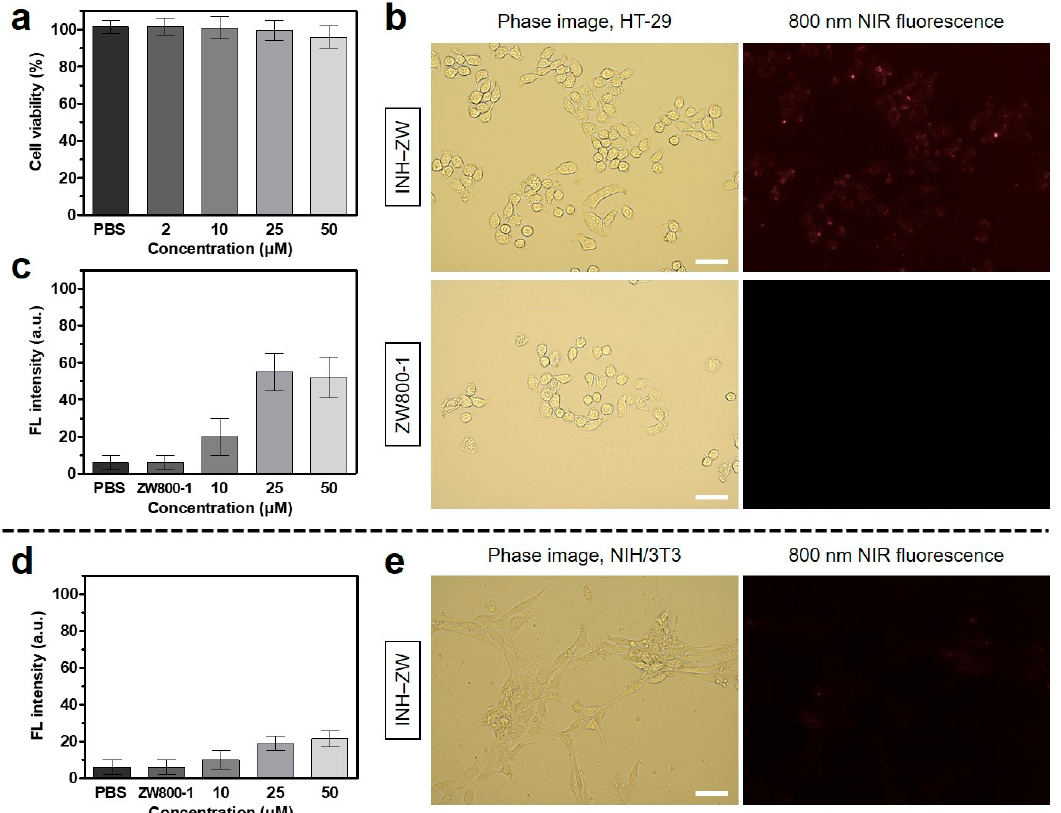
Figure 3. ( a ) Cell viability assay of the INH–ZW conjugate using HT-29 cancer cells. The percentage cytotoxicity was determined after 24 h of treatment with various concentrations of the INH–ZW conjugate. ( b ) Live cancer cell binding of the INH–ZW conjugate and ZW800-1 in HT-29 cells. Relative fluorescence intensities in ( c ) HT-29 and ( d ) NIH/3T3 cells 24 h after treatment with various concentrations of the INH–ZW conjugate or 25 μ M ZW800-1. ( e ) Live normal cell binding of the INH–ZW conjugate in NIH/3T3 cells. The phase contrast and NIR fluorescence images of the cell line were obtained using 25 μ M INH–ZW or ZW800-1. Data are expressed as the mean ± S.D. of the three independent experiments. Images are representative of three independent experiments. All NIR fluorescence images have identical exposure times and normalization. Scale bars = 100 μ m.